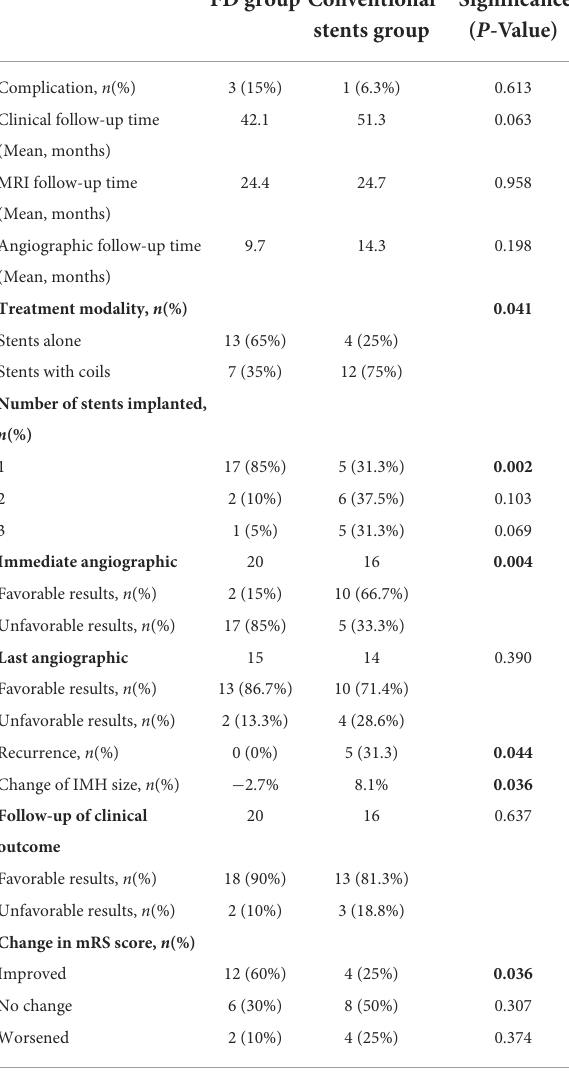
TABLE 1 Patient and aneurysm characteristics. TABLE 2 Angiographic and clinical